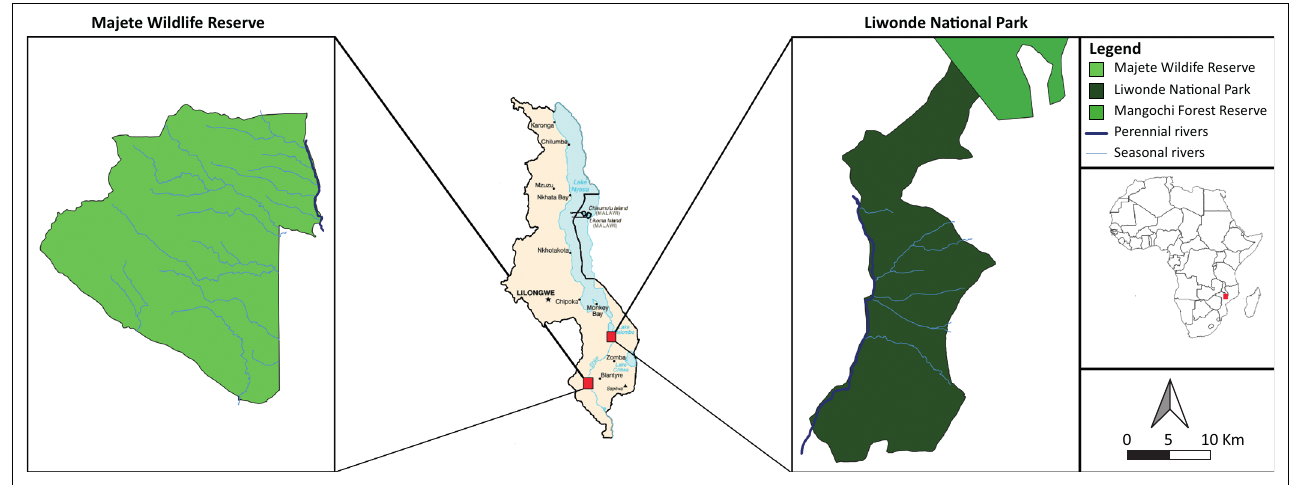
FIGURE 1: Africa is shown with Malawi’s location highlighted. A map of Malawi is also displayed in the centre, in which the locations of Majete Wildlife Reserve and Liwonde National Park can be seen. On the left, Majete Wildlife Reserve is displayed with perennial and seasonal rivers indicated, and on the right Liwonde National Park is shown with its perennial and seasonal